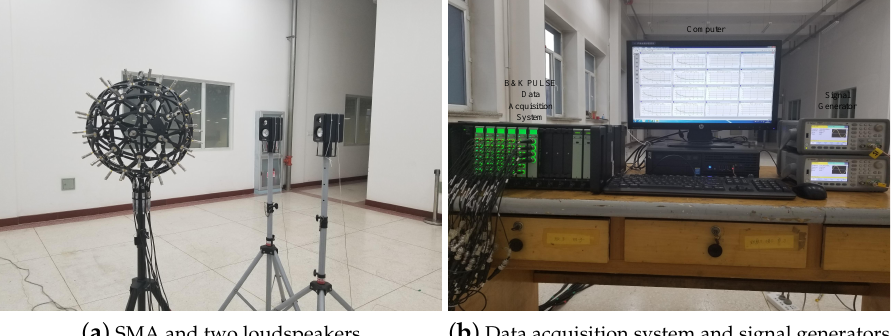
Figure 9. The set-up of the experiments conducted in a spacious room, with the SMA and the two loudspeakers tested shown in ( a ) and the B&K 64-channel PULSE Type 3660D data acquisition system and signal generators shown in ( b